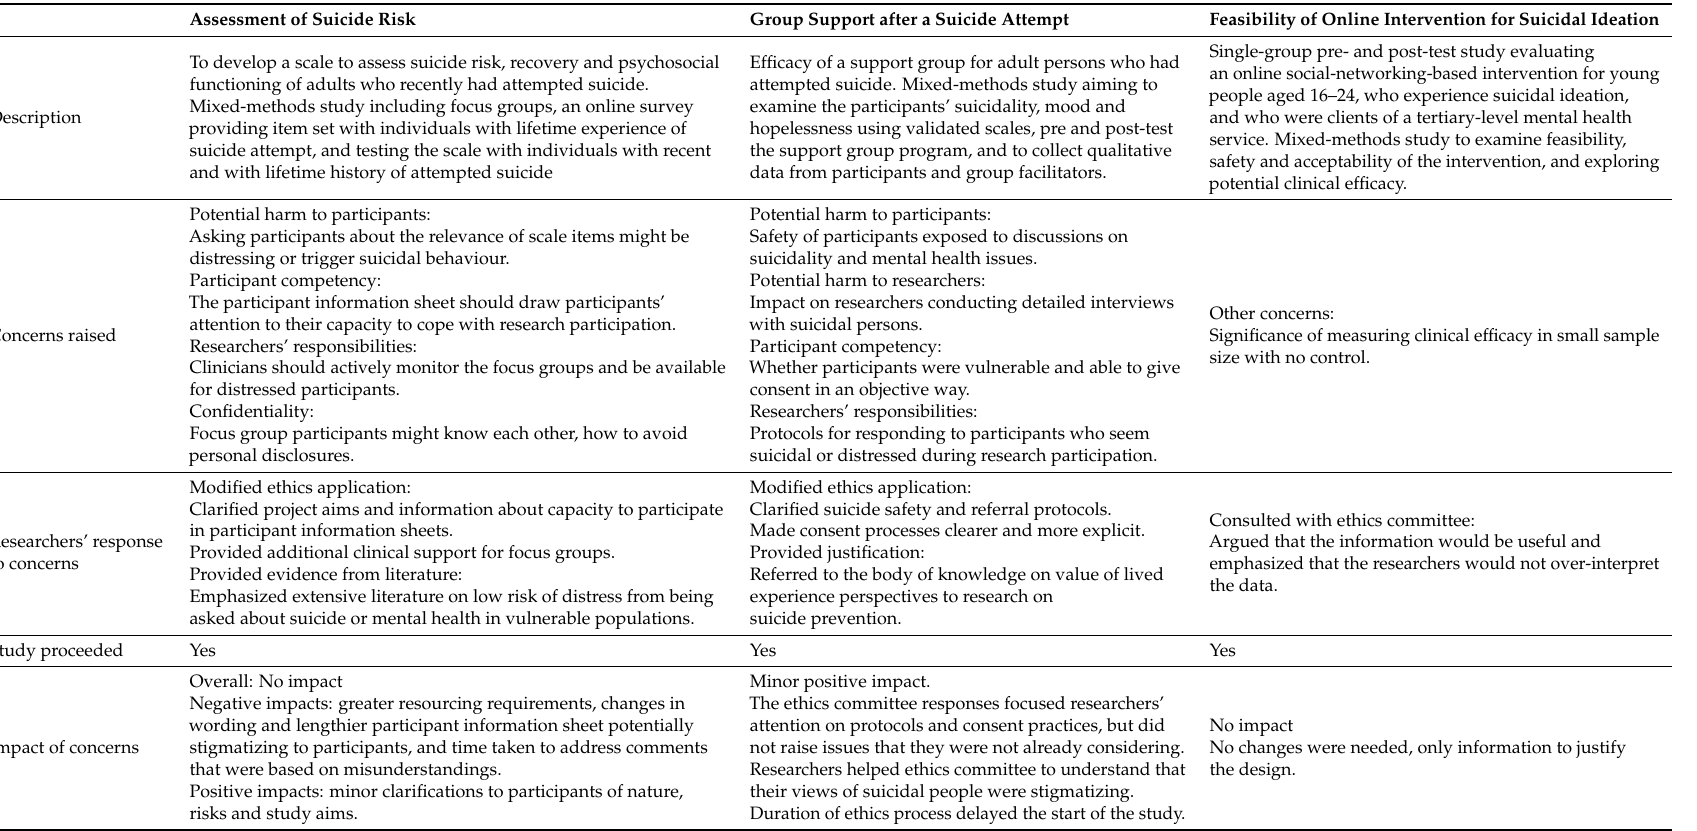
Table A1. Summary of sample ethics